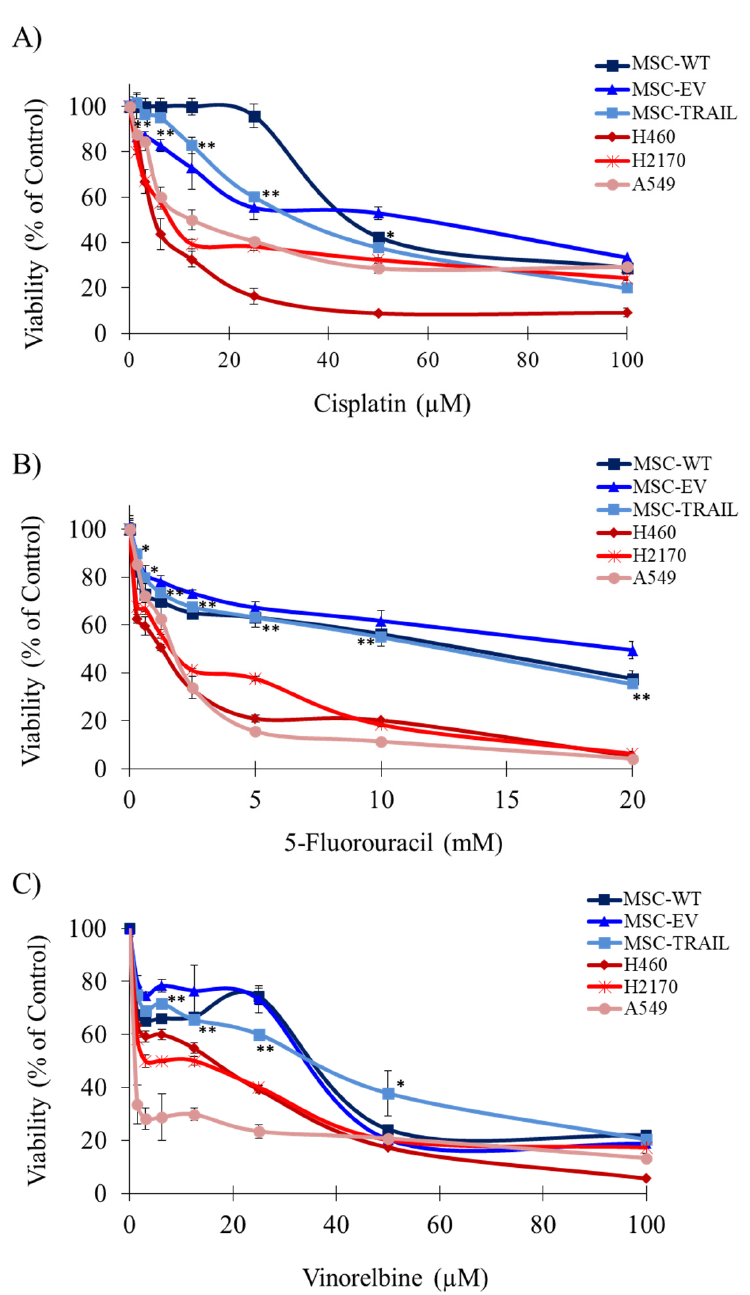
Figure 2. The cell viability of NSCLC cell lines (H460, H2170 and A549) and MSC variants (MSC-WT, MSC-EV and MSC-TRAIL) treated with chemotherapies. ( A ) Higher cell viability in all MSC variants compared to the NSCLC cell lines treated with cisplatin at concentrations lower than 40 µM. ( B ) A distinct separation in terms of cell viability was observed between NSCLC cell lines and the MSC variants at different 5-FU dosages. ( C ) Compared to the NSCLC cell lines, MSC variants were resistant to the vinorelbine treatment at concentrations lower than 40 µM. However, as the concentration increases to 100 µM, the cytotoxicity of vinorelbine becomes more prominent for all cells. ((* p < 0.01, ** p < 0.001; t -test (MSC-TRAIL vs NSCLC cell lines), n = 3)). WT, wild-type; EV, empty vector; 5-FU, 5-fluorouracil.